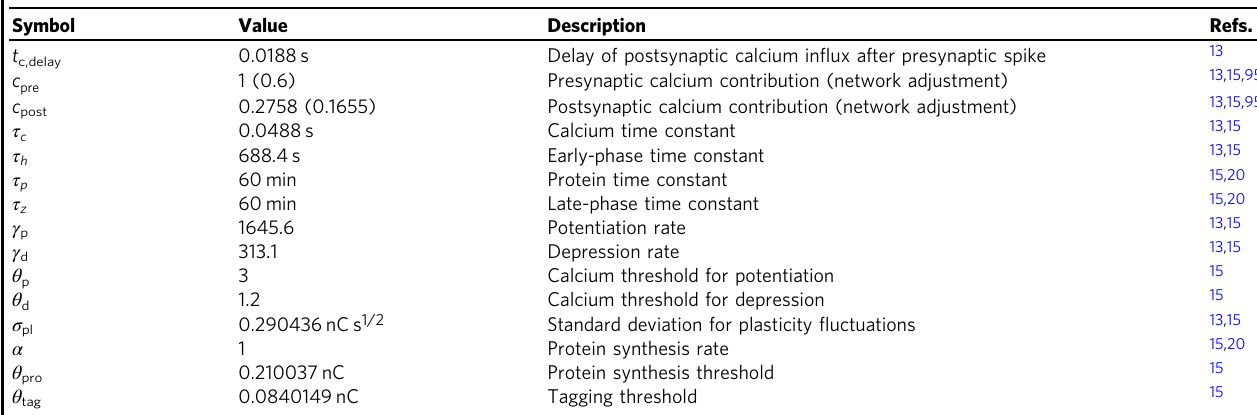
Table 2 Values were used as given in this table, unless stated